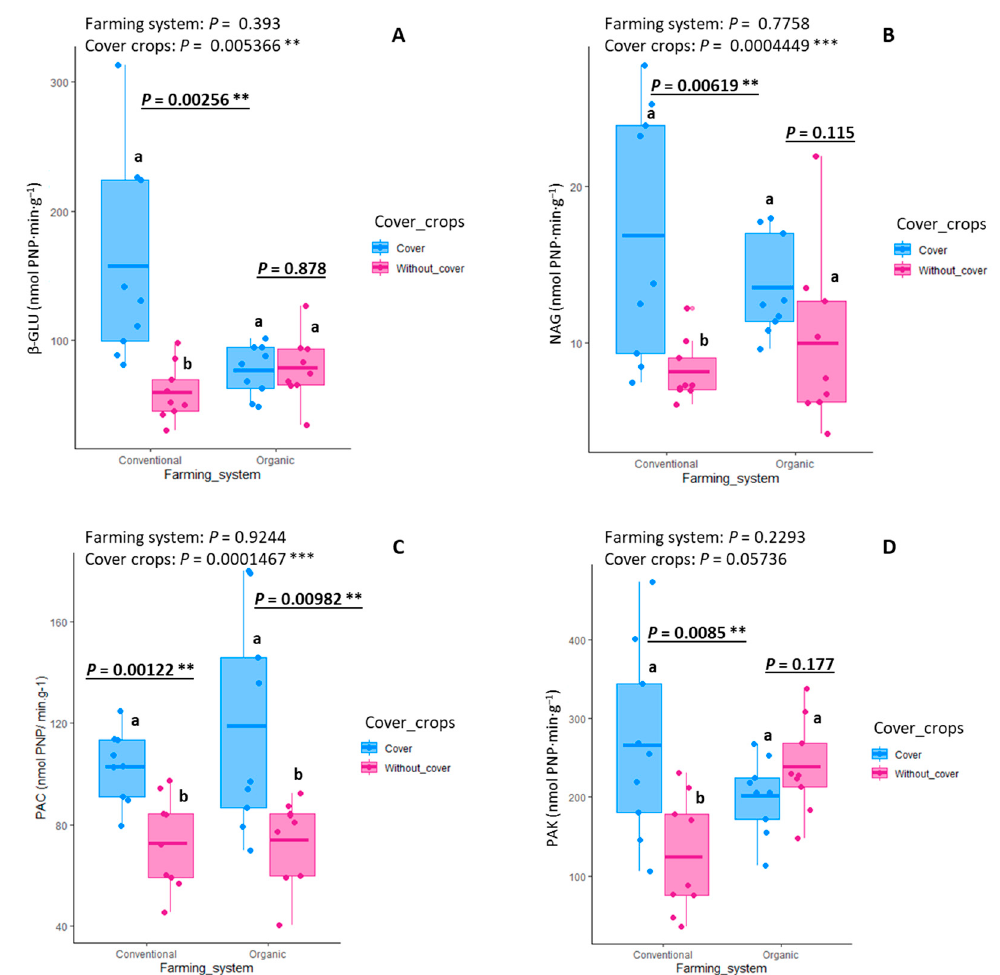
Figure 4. Effect of cover crops on activity of β -glucosidase ( β -GLU) ( A ), N-acetylglucosaminidase (NAG) ( B ), acid phosphatase (PAC) ( C ) and alkaline phosphatase (PAK) ( D ) in soil from the two farming systems (conventional and organic). The boxplots with p-values represents means of each modality using the Kruskal–Wallis test ( n = 36); means followed by the same letter do not differ significantly under the Wilcoxon test at the 0.05 level; significant levels: ** p < 0.01; *** p < 0.001.